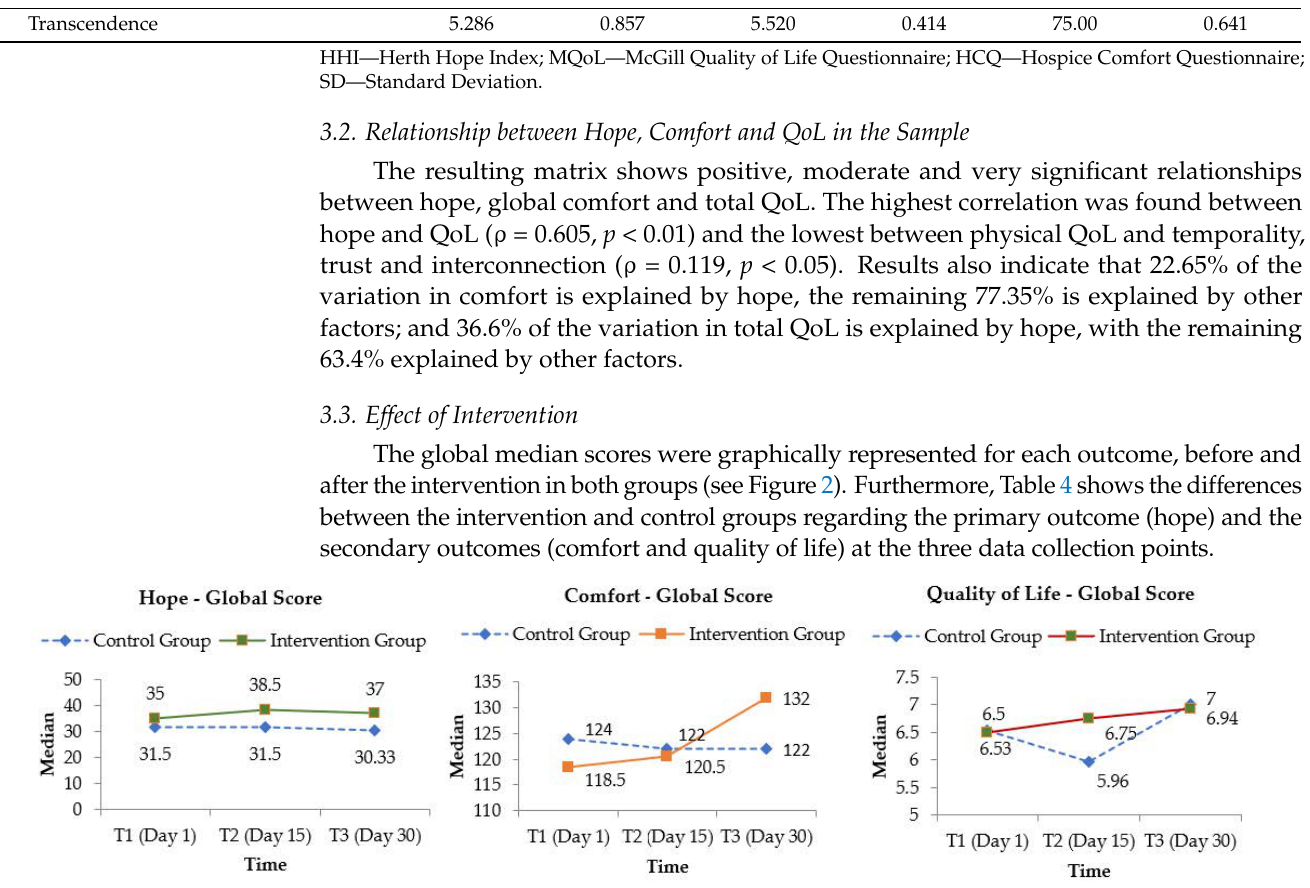
Figure 2. Global median scores evolution of the primary and secondary outcome measures.